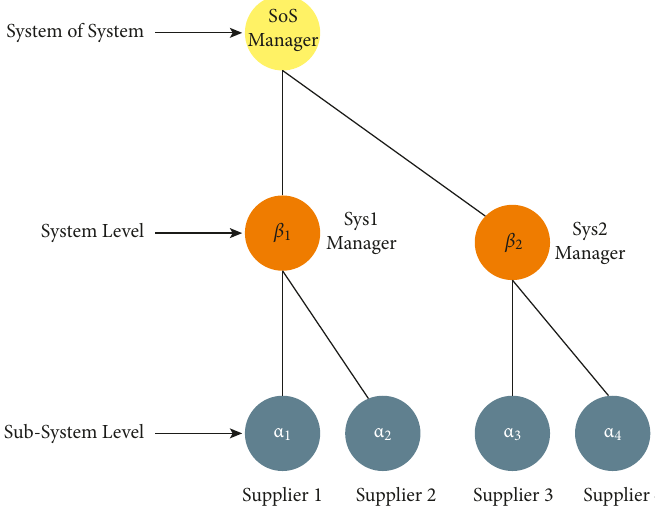
Figure 1: Conceptual model.